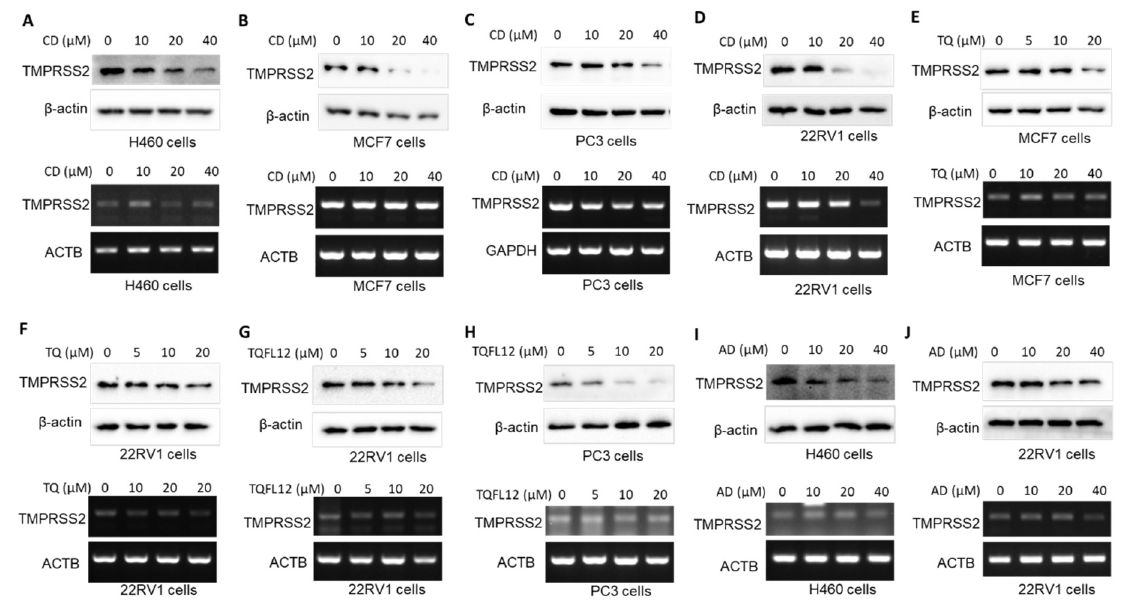
Figure 5. CD, TQ, TQFL12, and AD inhibit TMPRSS2 expression in various cancer cell lines. ( A ) CD inhibited TMPRSS2 expression in H460 cells. ( B ) CD inhibited TMPRSS2 expression in MCF7 cells. ( C ) CD inhibited TMPRSS2 expression in PC3 cells. ( D ) CD inhibited TMPRSS2 expression in 22RV1 cells. ( E ) TQ inhibited TMPRSS2 expression in MCF7 cells. ( F ) TQ inhibited TMPRSS2 expression in 22RV1 cells. ( G ) TQFL12 inhibited TMPRSS2 expression in 22RV1 cells. ( H ) TQFL12 inhibited TMPRSS2 expression in PC3 cells. ( I ) AD inhibited TMPRSS2 expression in H460 cells. ( J ) AD inhibited TMPRSS2 expression in 22RV1 cells.